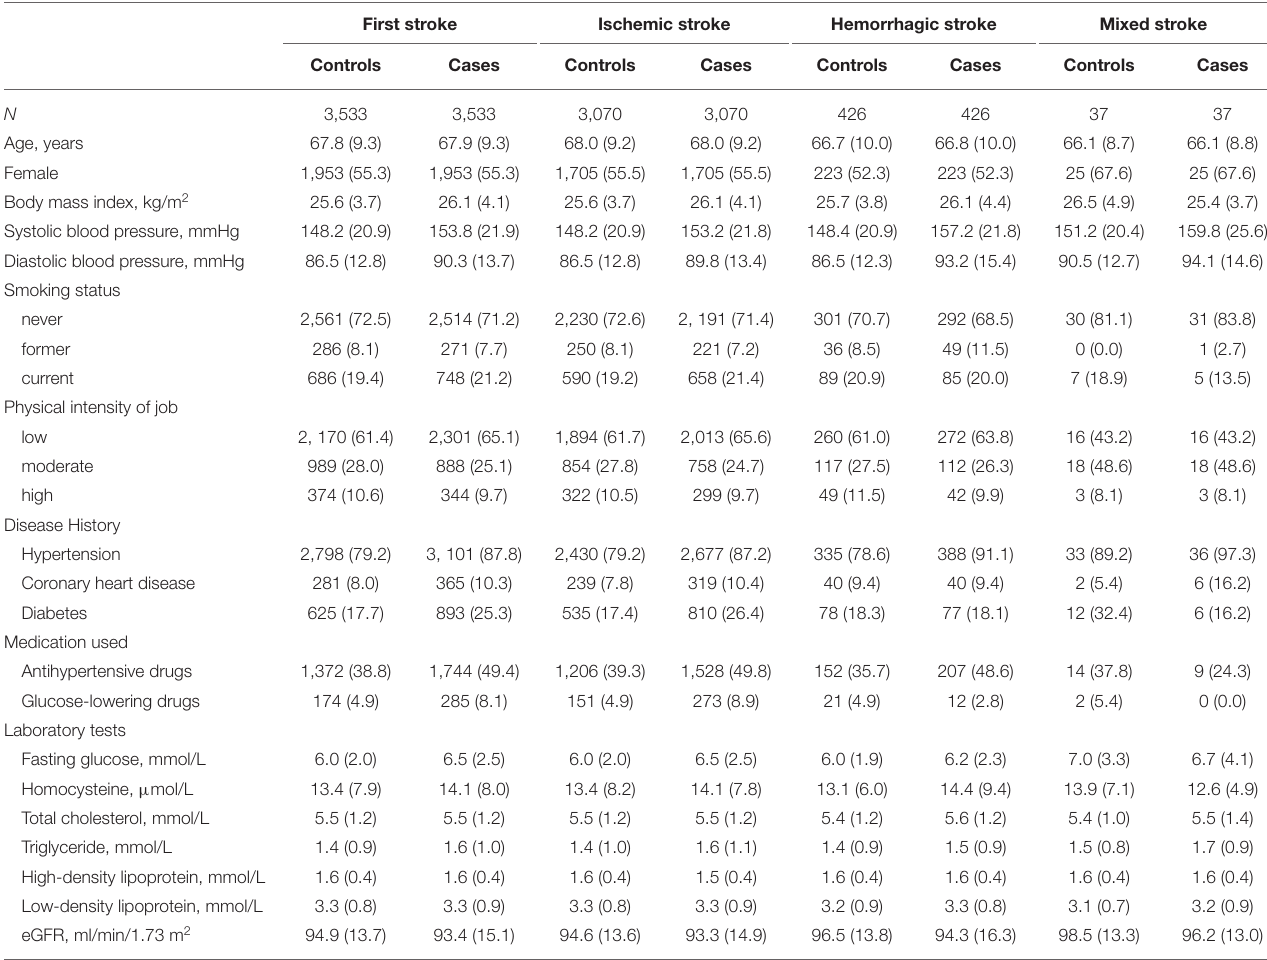
TABLE 1 | Baseline characteristics of the study participants. First stroke Ischemic stroke Hemorrhagic stroke Mixed stroke Controls Cases Controls Cases Controls Cases Controls